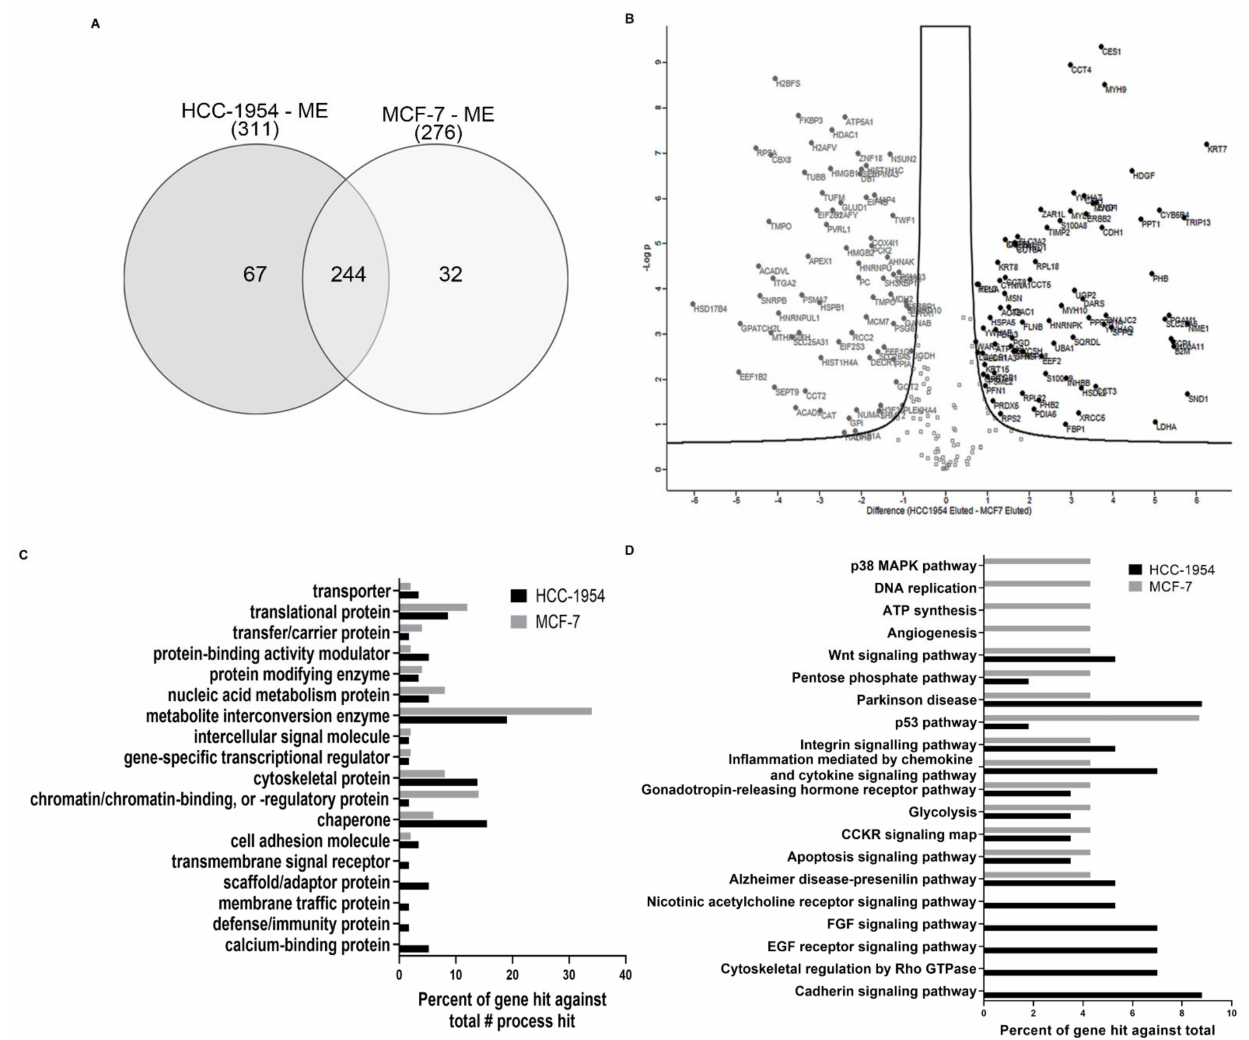
Figure 2. Proteomic data Analysis ( A ) Interactive Venn diagram of the 343 proteins identified and quantified with a 95% confidence level (ANOVA p ≤ 0.05) in the Progenesis QI analysis of our label-free proteomic data of HCC-1954 and MCF-7 ME fractions. ( B ) Volcano plots of all proteins from HCC-1954 and MCF-7 ME fractions. Proteins with increased fold change ratio are indicated by black circles, whereas the grey circles denote those proteins presenting a decreased fold change ratio (Data are available in Supplementary Table S2). ( C ) GO Panther classification of increased proteins with a relative fold change higher than 2 (0.5 < FC > 2) for the ratio HCC-1954 ME/MCF-7 ME in the Protein class and ( D ) Pathway